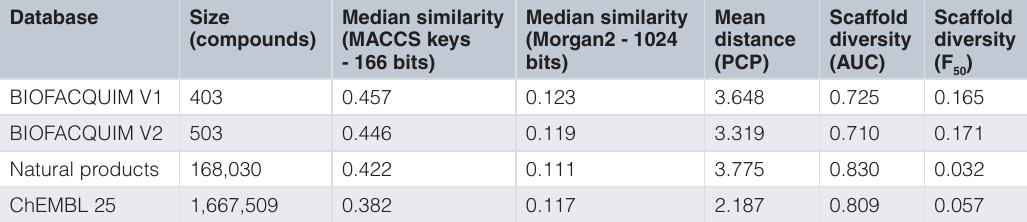
Table 1. Compound databases analyzed in this work and summary statistics of their diversity.